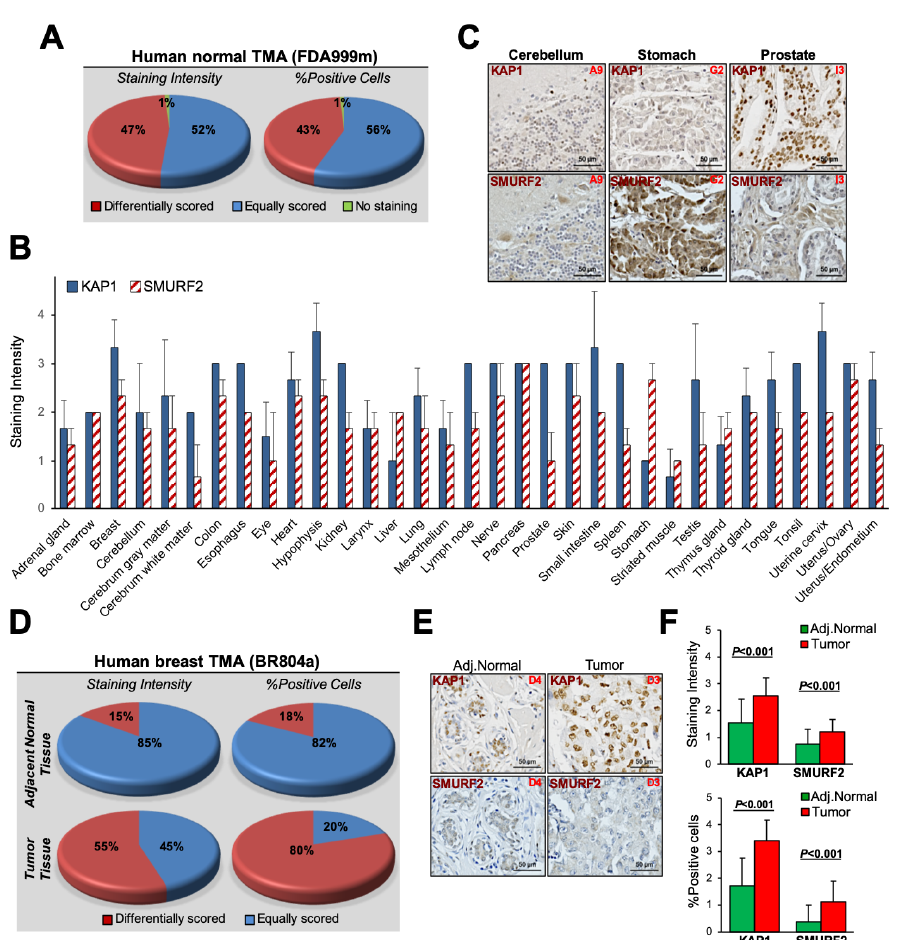
Figure 5. Analysis of the SMURF2–KAP1 relationship in human normal and cancer tissues. ( A ) Sum ‐ mary of the quantification analysis of SMURF2 and KAP1 staining intensity and percentage of